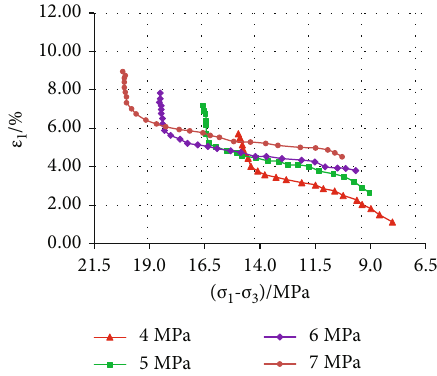
Figure 3: Mechanical characteristic curves in the axial pressure unloading of coal specimens under a constant atmospheric pressure of 1.5 MPa and di ff erent con fi ning